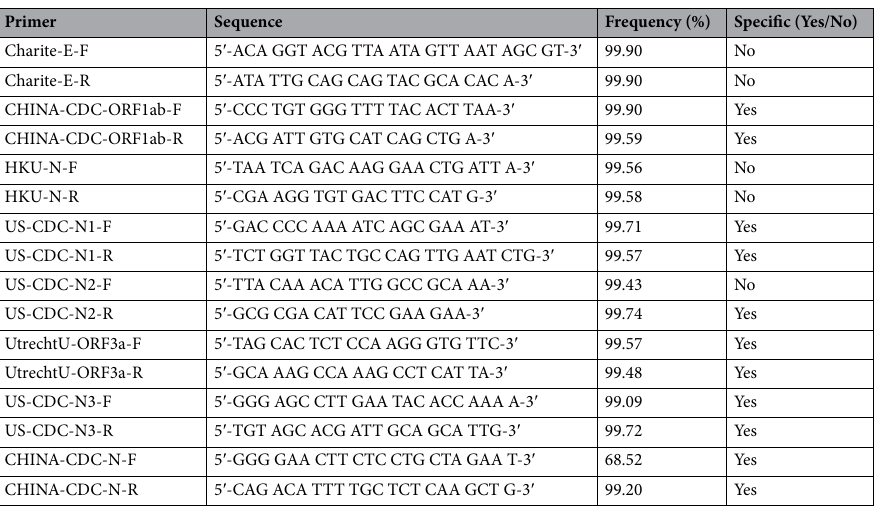
Table 2. Comparison of primer sets developed by WHO referral labs, against the primer set obtained by the proposed approach, listed as UtrechtU-ORF3a . The Frequency column indicates frequency of appearance of the sequence among samples of the GISAID dataset. The Specific (Yes/No) column shows whether the sequence appears to be unique to SARS-CoV-2 samples, or can also be found in other viruses, according to the evaluation on the NCBI-B and NGDC datasets.